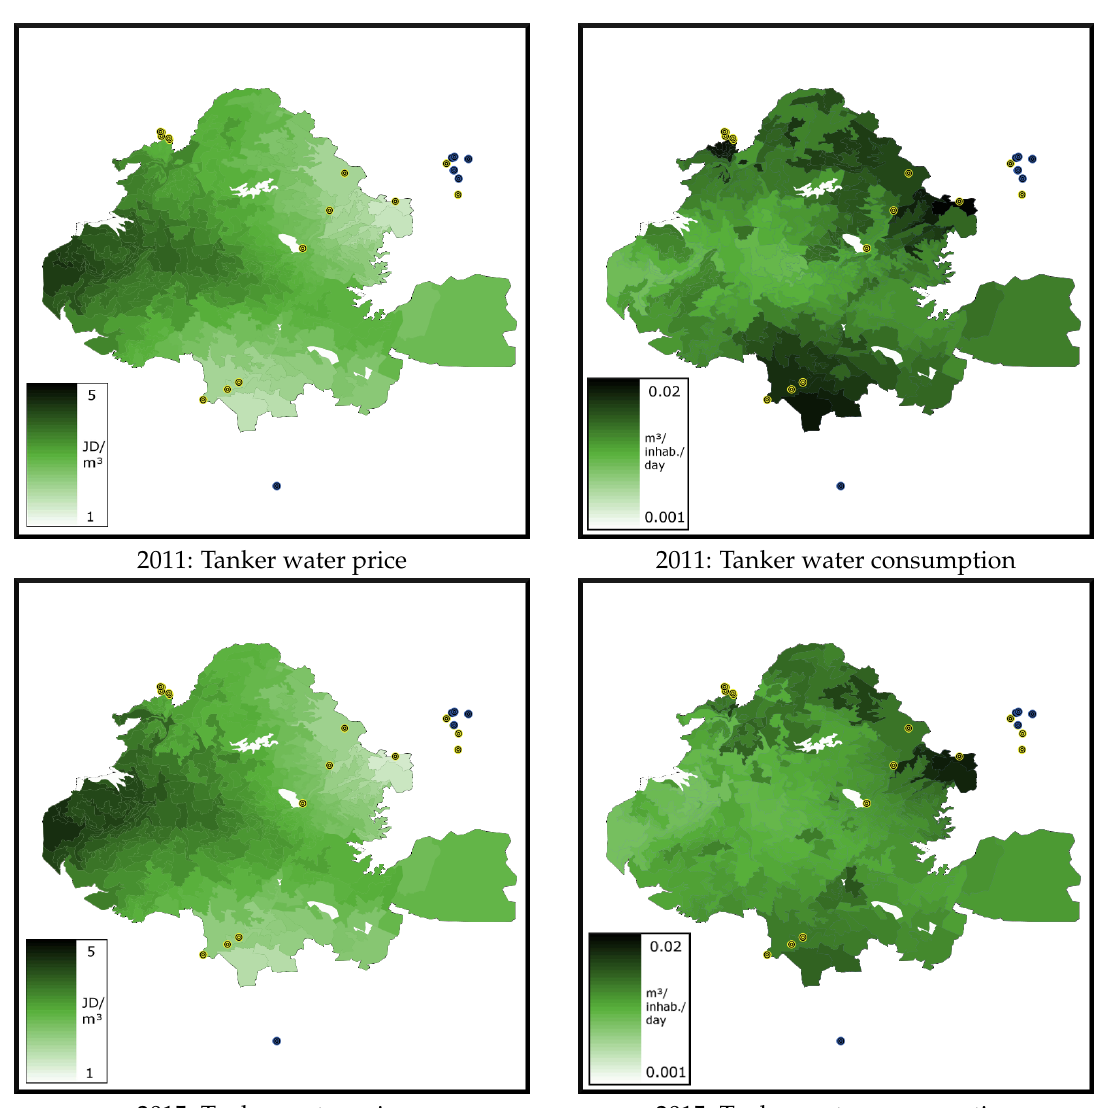
Figure 4. Simulation results: Average tanker water prices and consumption quantities per distribution zones (DZ) for the years 2011 and 2015. Fully exploited well fields are indicated by yellow spirals, while those with pumping capacities left at the end of the day are marked in